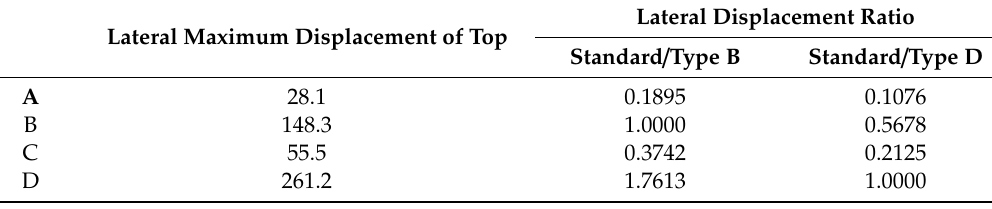
Table 7. Lateral displacement ratio according to type of retaining